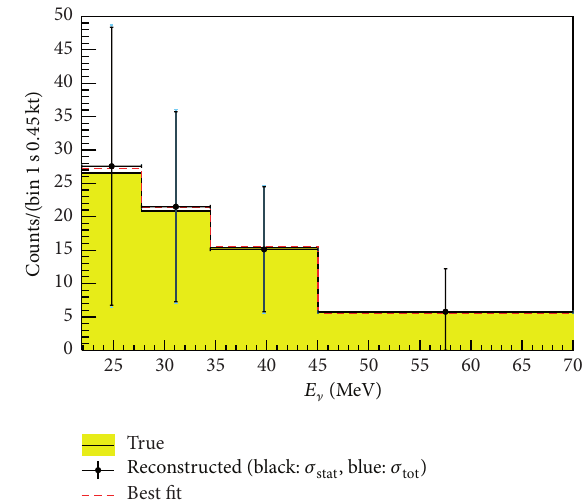
Figure 9: True, reconstructed, and best fit SN neutrino energy distribution of the ] -p ES detection channel within the FV and above the detector threshold [16]. Shown is the sum of the ] 𝑒 , ] 𝑒 , and ] 𝑥 spectra, considering their time-integrated flux in the first second of the reference SN. The statistical uncertainties are shown in black, while the total uncertainties are shown in blue. The contribution from systematic uncertainty is too small to be